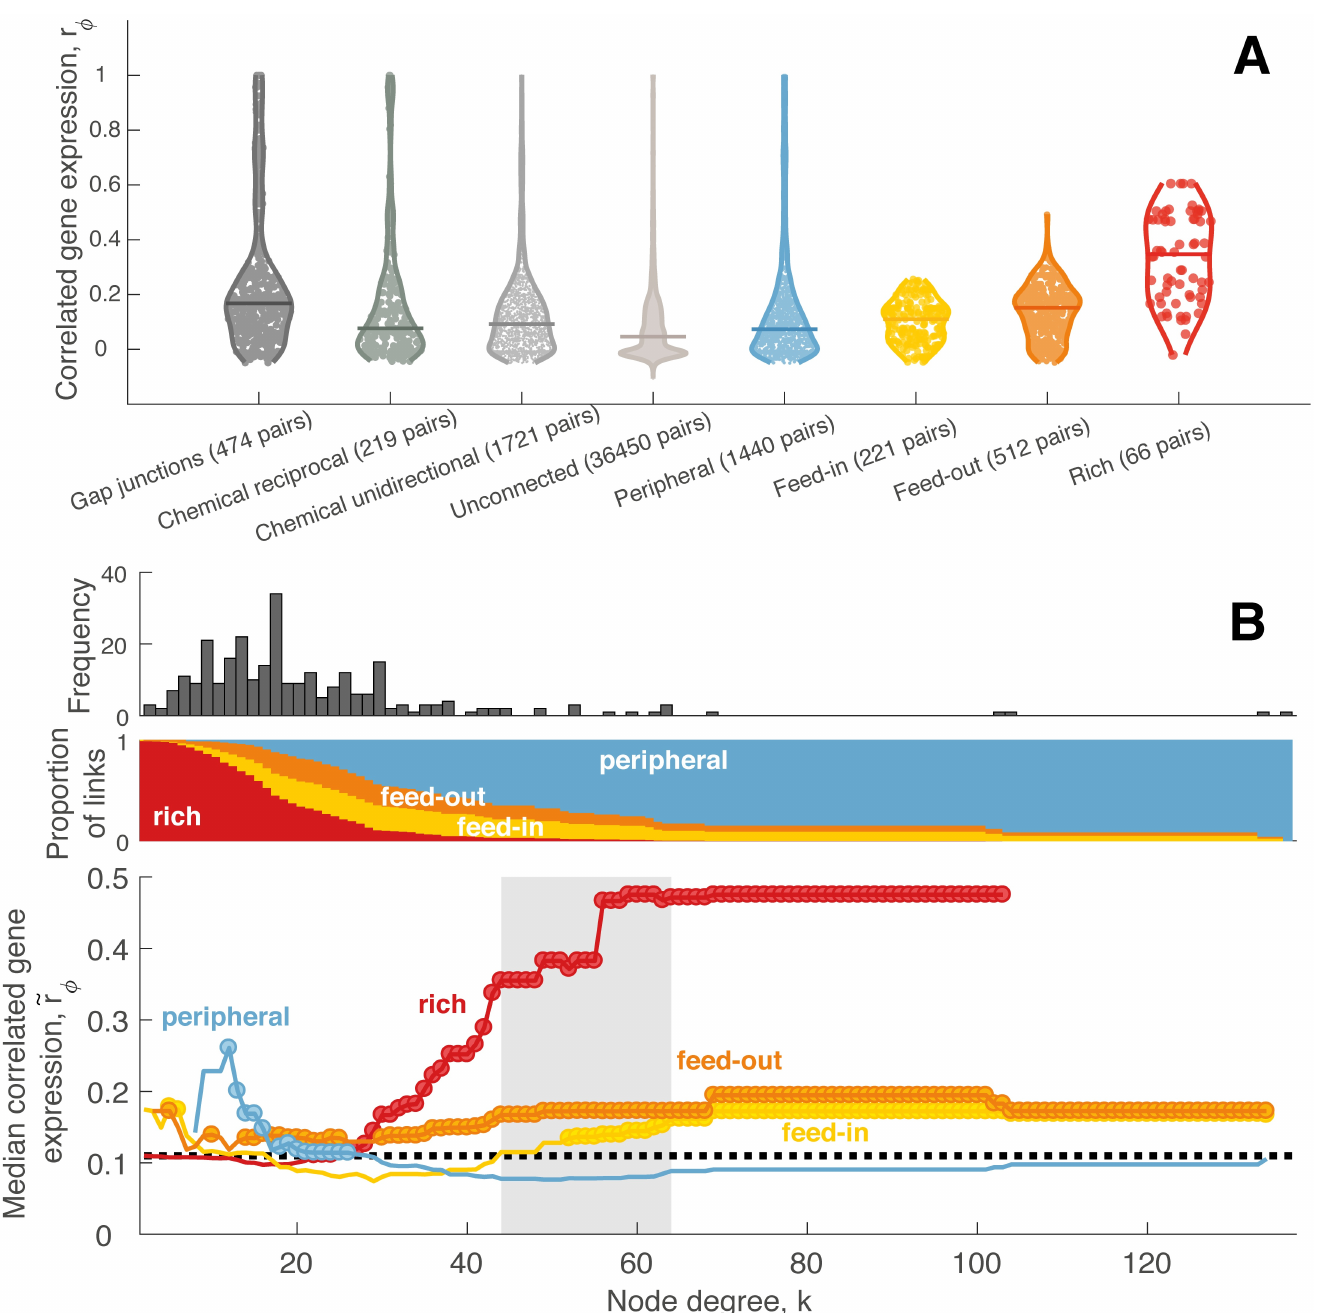
Fig 6. Correlated gene expression varies as a function of connectedness and connection type. (A) Left : distribution of CGE for (i) pairs of neurons connected by gap junctions, (ii) pairs of neurons connected by reciprocal chemical synapses, (iii) pairs of neurons connected by unidirectional chemical synapses, (iv) pairs of neurons that are unconnected, shown as a violin plot, with the median of each distribution represented by a horizontal line. CGE is increased in connected (electrical or chemical; reciprocally or unidirectionally) pairs of neurons relative to unconnected pairs ( p = 1.8 × 10 −78 , Wilcoxon rank sum test). Among connected pairs of neurons neurons connected via gap junctions have more similar CGE than connected via chemical synapses (Wilcoxon rank-sum test, p = 5.4 × 10 −22 ). Right : GCE for pairs of neurons labeled as peripheral, feed-in, feed-out, and rich, where hubs are neurons with degree k > 44. The median of each distribution shown as a horizontal line. CGE is significantly higher between hubs (rich links) compared to feeder ( p = 5 × 10 − 22 , Wilcoxon rank sum test) and peripheral ( p = 3.9 × 10 − 19 , Wilcoxon rank sum test) links. Feed-out links show significantly higher CGE than both feed-in ( p = 1.9 × 10 −6 , Wilcoxon rank sum test) and peripheral links ( p = 4.5 × 10 −12 , Wilcoxon rank sum test). (B) Top : Degree distribution, k , of the C. elegans connectome. Middle : proportion of connections that are: ‘rich’ (hub ! hub, red), ‘feed-in’ (nonhub ! hub, yellow), ‘feed-out’ (hub ! nonhub, orange), or ‘peripheral’ (nonhub ! nonhub, blue) as a function of the degree threshold, k , used to define hubs. Note that at high k most neurons are labeled as nonhubs and hence the vast majority of connections are labeled ‘peripheral’. Bottom : Median CGE, ~ r